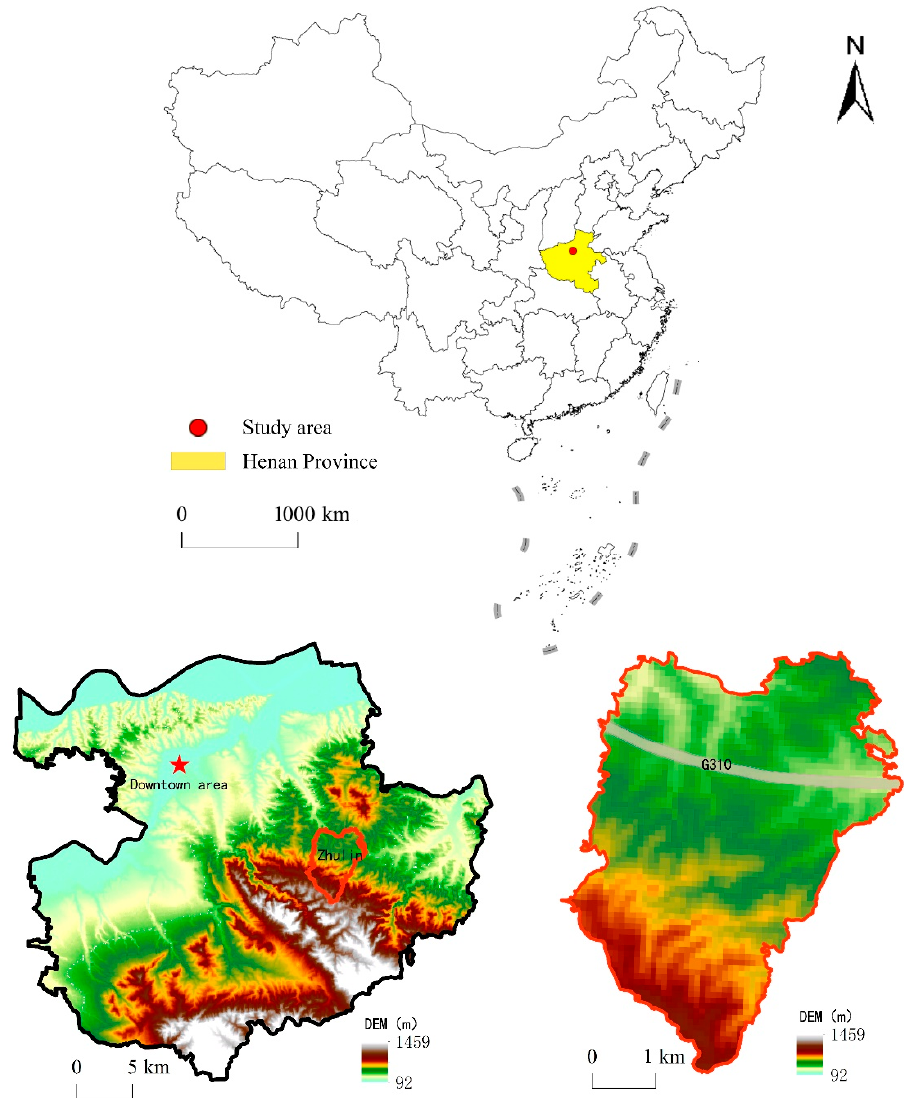
Figure 2. Geographical location and topographic characteristics of Zhulin in 2019. Reference system GCS Xian 1980.